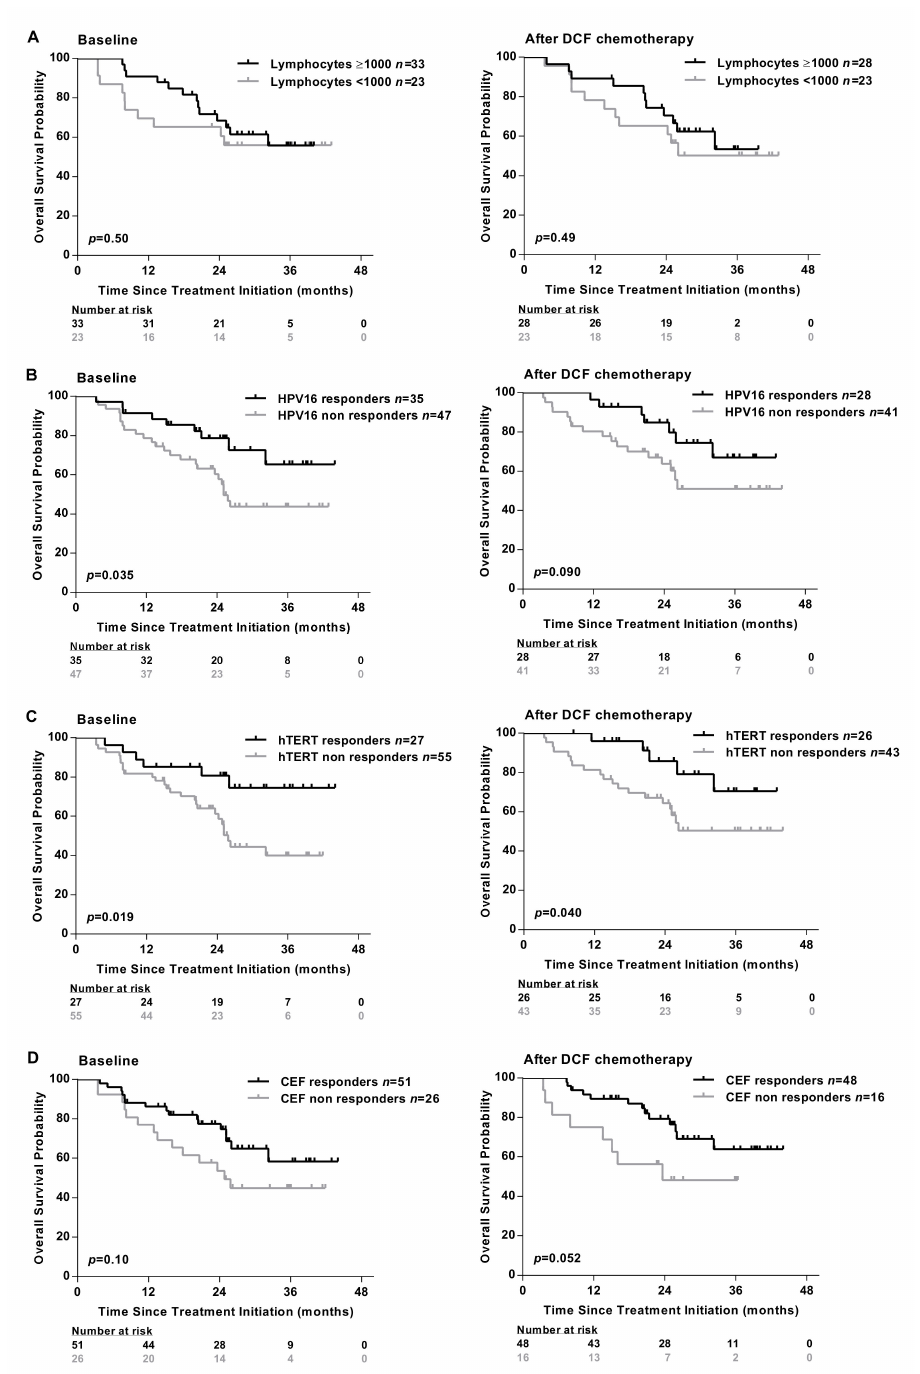
Figure 2. Presence of antigen-specific T-cell responses are associated with the clinical outcomes of SCCA patients. ( A ) The absolute lymphocyte count was analyzed in peripheral blood of SCCA patients before ( n = 56) and after ( n = 51) DCF chemotherapy. Kaplan-Meier curve in SCCA patients before and after DCF chemotherapy according to low absolute lymphocyte count. PBMC from SCCA patients before ( n = 82) and after ( n = 69) DCF chemotherapy were analyzed for antigen-specific T-cell responses by IFN γ ELISpot assay. ( B , C ) Kaplan-Meier OS curve in SCCA patients according to HPV (E6 and / or E7) ( B ) or hTERT ( C ) specific T-cell responses before and after DCF chemotherapy. Log-rank test, where p < 0.05. ( D ) Kaplan-Meier OS curve in SCCA patients according to antiviral-specific T-cell responses before and after DCF